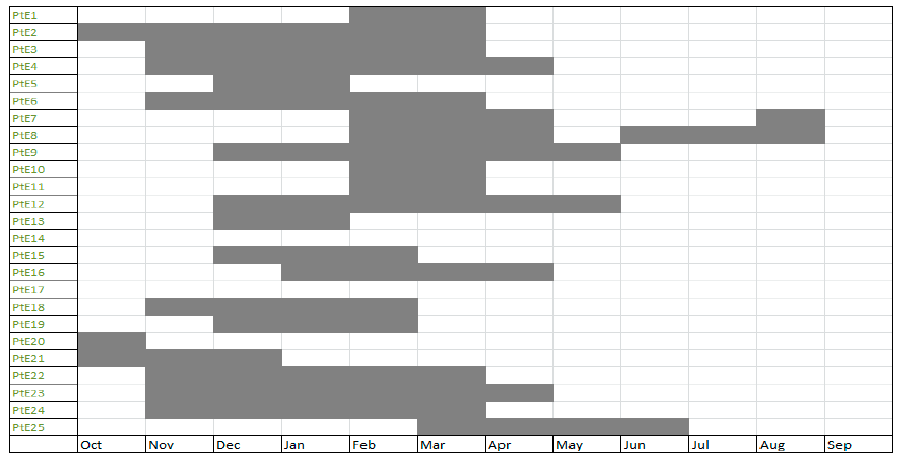
Figure 5. The time duration and season of pruning activities in the investigated PtE value chains (source: authors own illustration).